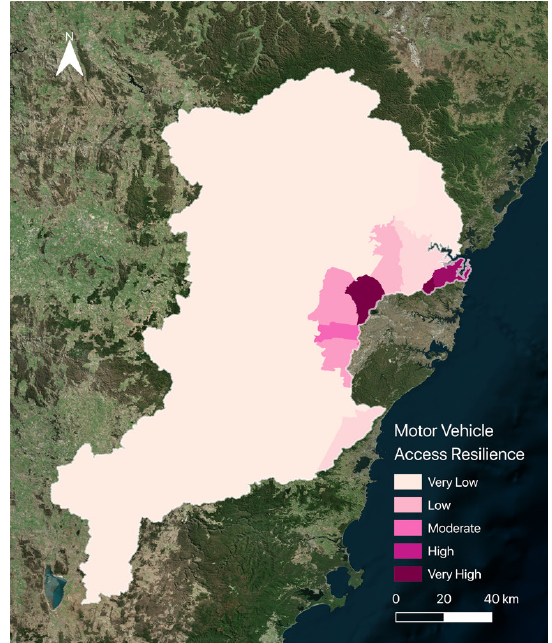
Figure 4. Motor Vehicle Access Resilience after standardising using fuzzy membership processing. Resilience measured from Very Low (light pink) to Very High (dark pink).